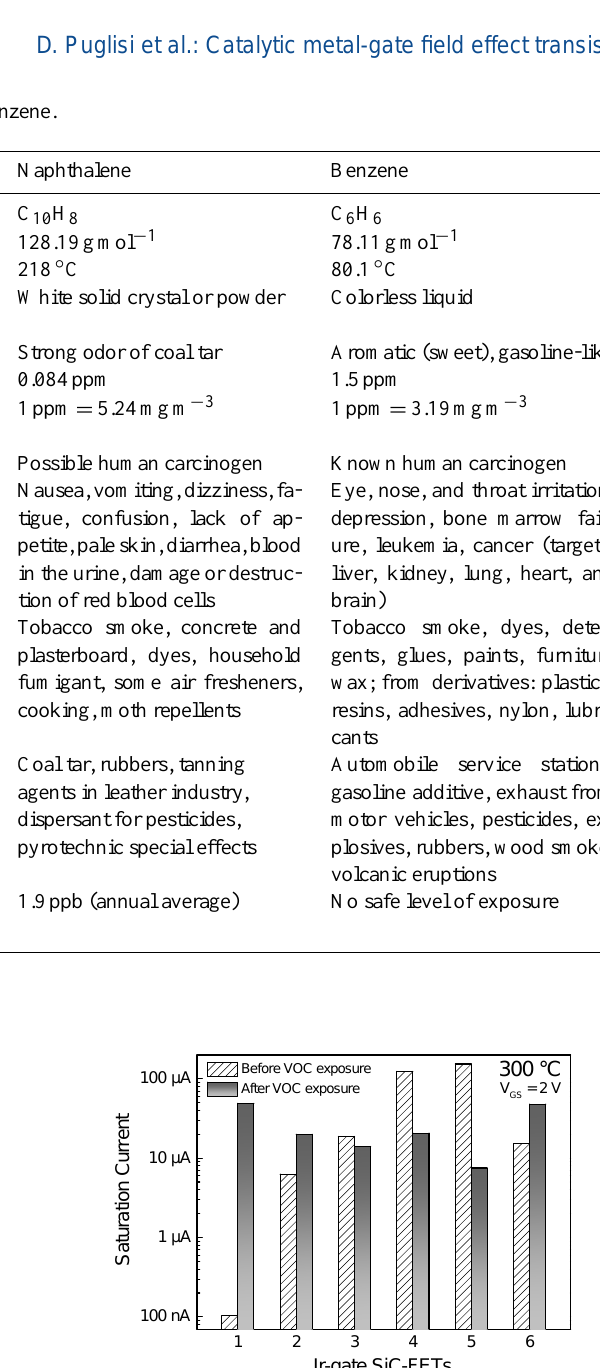
drop between drain and source, V DS , was the sensor signal. Different concentrations of formaldehyde (CH 2 O), naphtha- lene (C 10 H 8 ) , and benzene (C 6 H 6 ) were used to study the sensor’s performance and characteristics. Sensor response, detection limit, sensitivity, response and recovery times, and repeatability of the sensor response were studied in dry air as well as in a humid